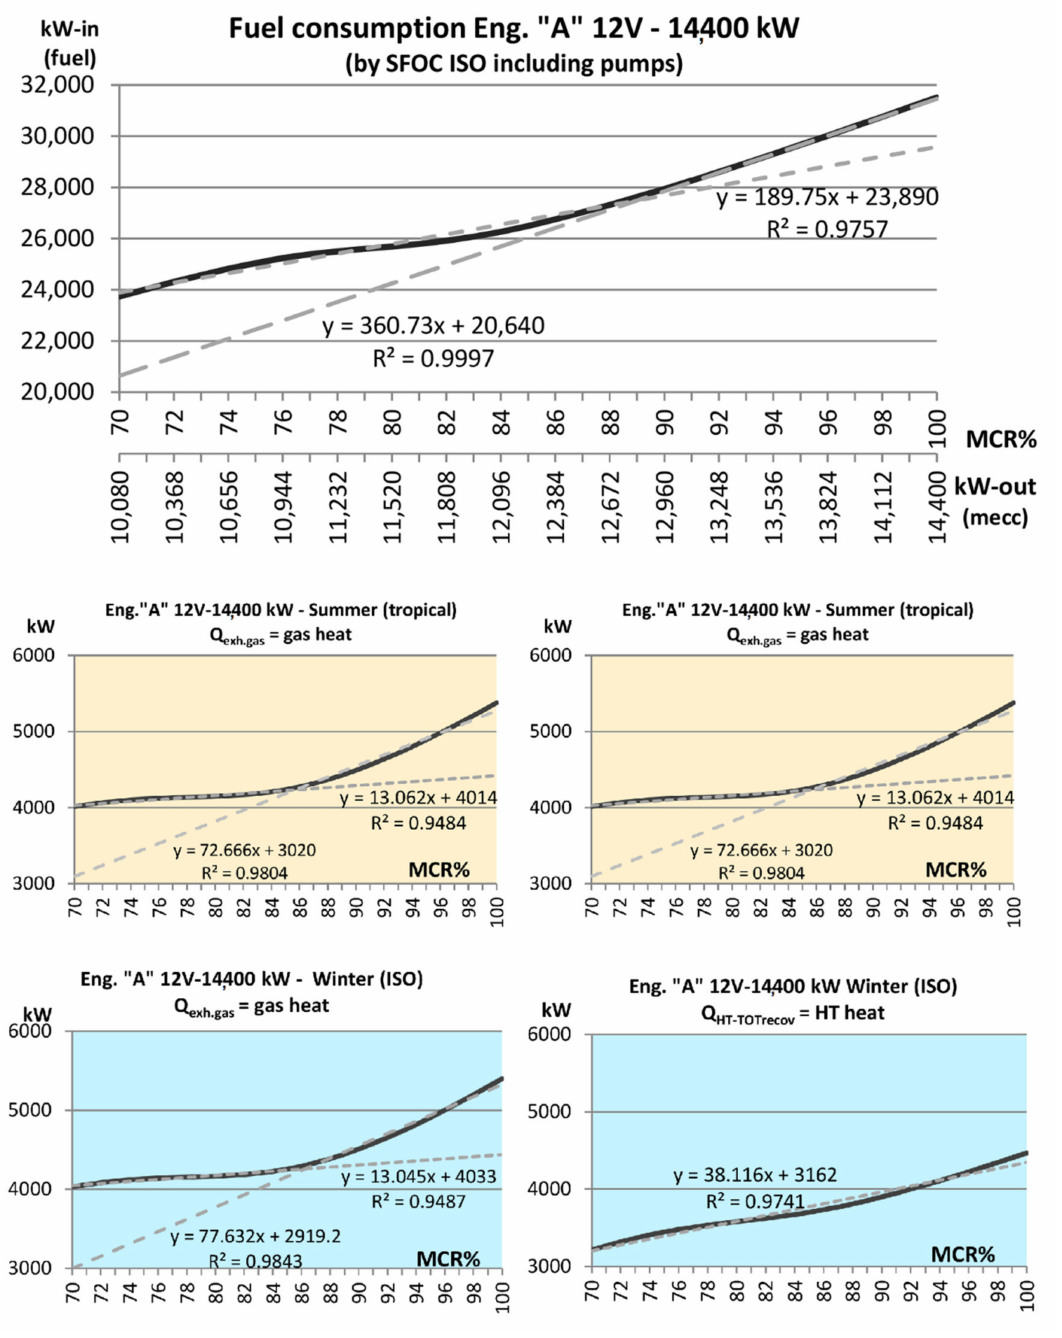
Figure 6. Operating curves of the Internal Combustion Engine (ICE) 12V, with the linearized